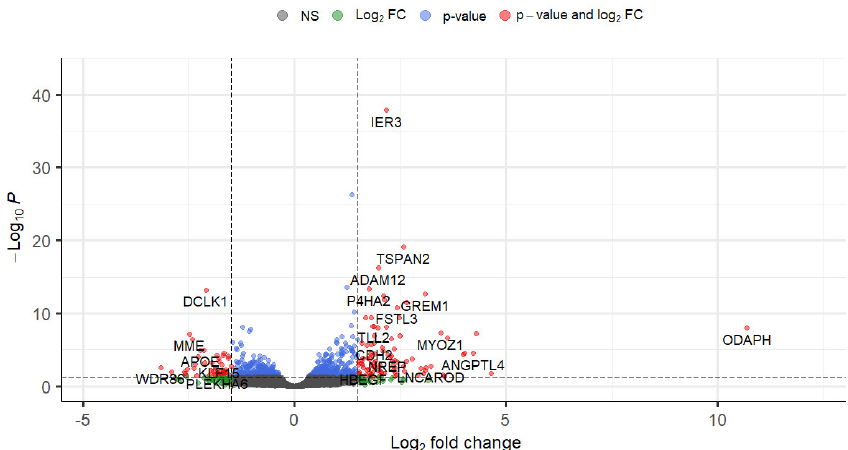
Figure 1. Volcano plot identifying differentially expressed genes in response to TGF-β1. Where grey and green dots = not significant when using false discovery rate corrected for multiple testing (where FDR > 0.05), blue dots represent genes with FDR < 0.05 and |log 2 FC| ≤ 1.5, red dots represent genes that are both significantly expressed and have a high fold-change: FDR < 0.05 and |log 2 FC| > 1.5. There were 143 genes with FDR < 0.05 and |log 2 FC| > 1.5 (marked in red) of which 95 genes were upregulated and 48 genes were downregulated. In this work all genes with FDR < 0.05 and |log 2 FC| > 0.26 have been taken into account (all red genes and most blue genes) which amounts to 689 genes of which 392 genes were upregulated and 297 genes were